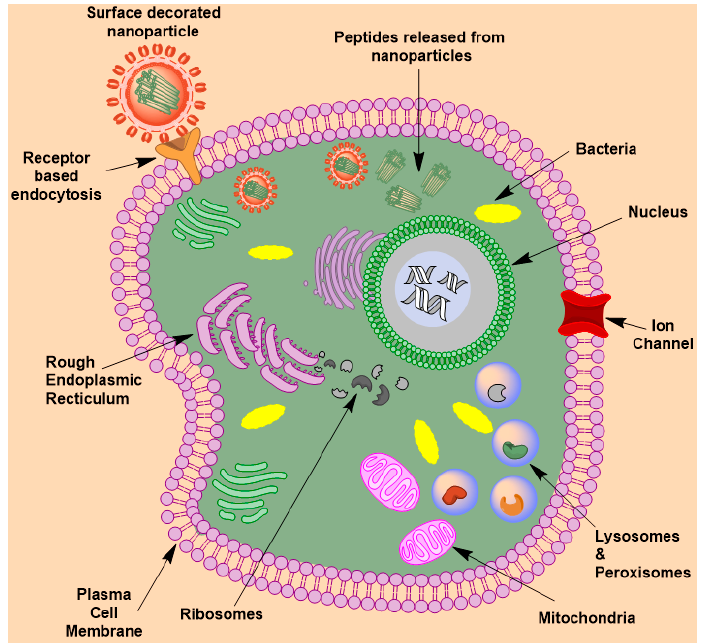
Figure 2. Receptor-mediated endocytosis of peptide encapsulated nanostructure across the cellular membrane.